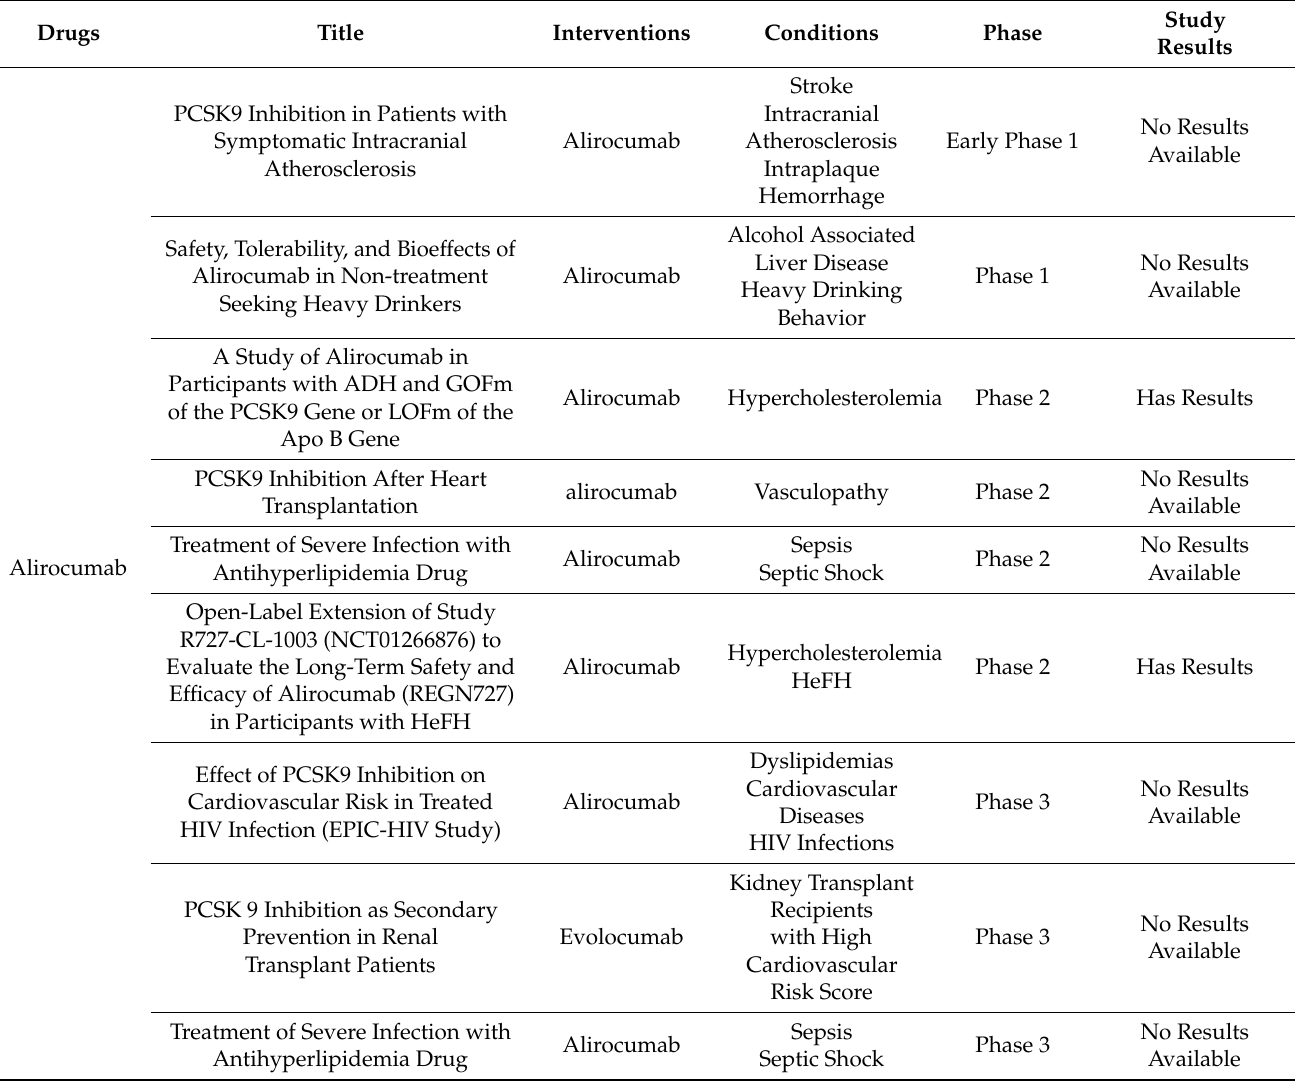
Table A1. Preclinical study of PCSK9 drug (Reference data from https://clinicaltrials.gov/, accessed on 1 January